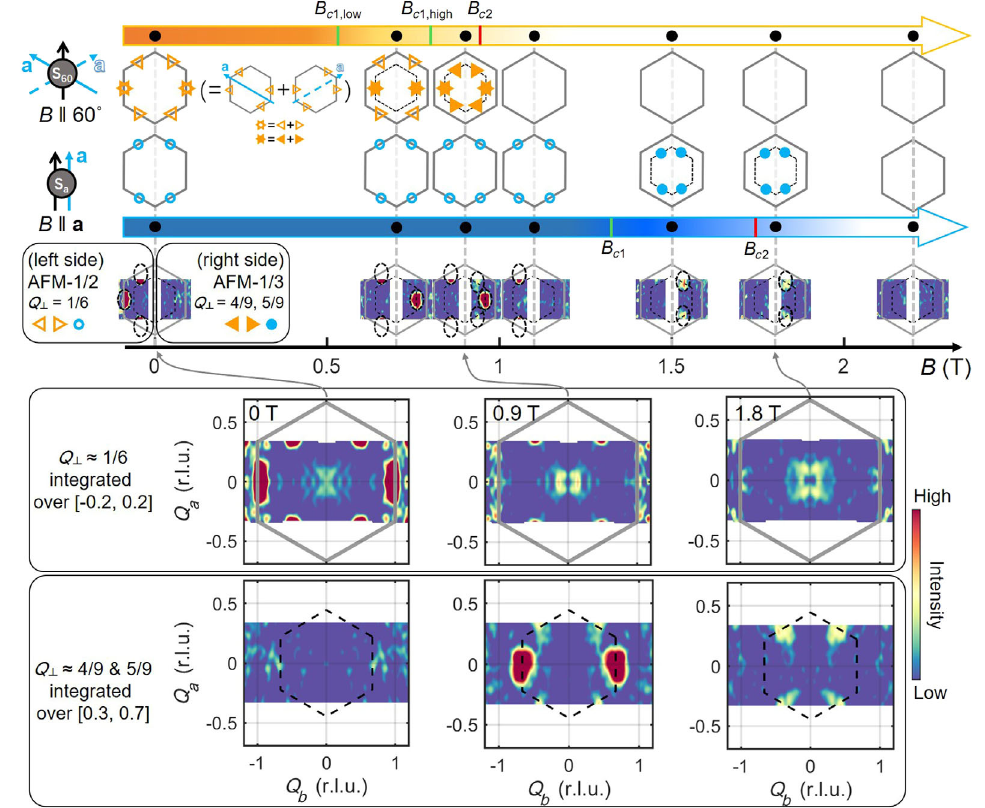
FIG. 4. The upper half illustrates the behavior of two sample parts ( S or S 60 ; see legends on the left and text) as the field passes a through their respective phase boundaries [Fig. 2(d)]. S is uniquely defined as per the in-plane orientation, and it contributes a diffractions indicated by blue circles. S 60 further contains two parts that are related by 180° rotation about the field, which contribute and AFM 1 wave vectors diffractions indicated by left- and right-pointing orange triangles. Empty and filled symbols indicate AFM 1 2 3 (see the text), respectively, which are measured by restricting Q ⊥ to ½ − 0 . 2 ; 0 . 2 (cid:2) and [0.3, 0.7], respectively. Miniatures of diffraction data (measured at T ¼ 0 . 25 K) are displayed in the bottom row of the illustration in a left-right split fashion, where the observed diffraction peaks (encircled by dashed ellipses centered at their expected locations, some of which fall beyond the data coverage) are fully þ S ” combination of the cartoons. Solid and dashed hexagons are the first Brillouin zone and 2 = 3 of it, consistent with the “ S 60 a respectively. In the lower half, we display diffraction data measured at three selected fields, where the solid and dashed hexagons have the same meaning as in the upper-half illustration. Note that the vertical ( k Q ) data coverage is limited and the resolution is relatively a poor compared to those in Fig. 3. An animated view of the full variable-field data is presented in Fig. S10 in Ref.